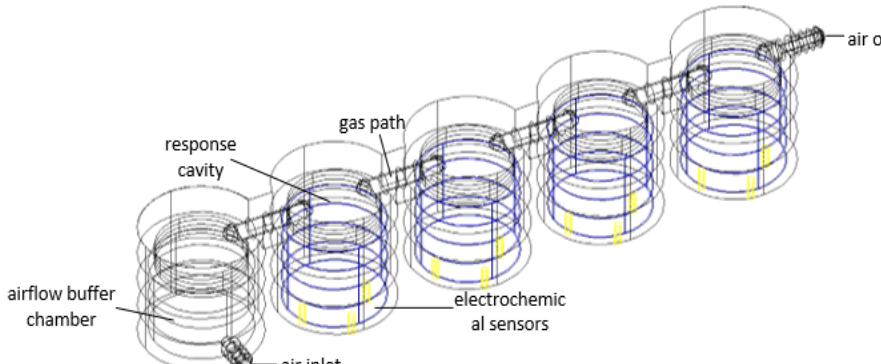
Figure 13. Series cavity structure.